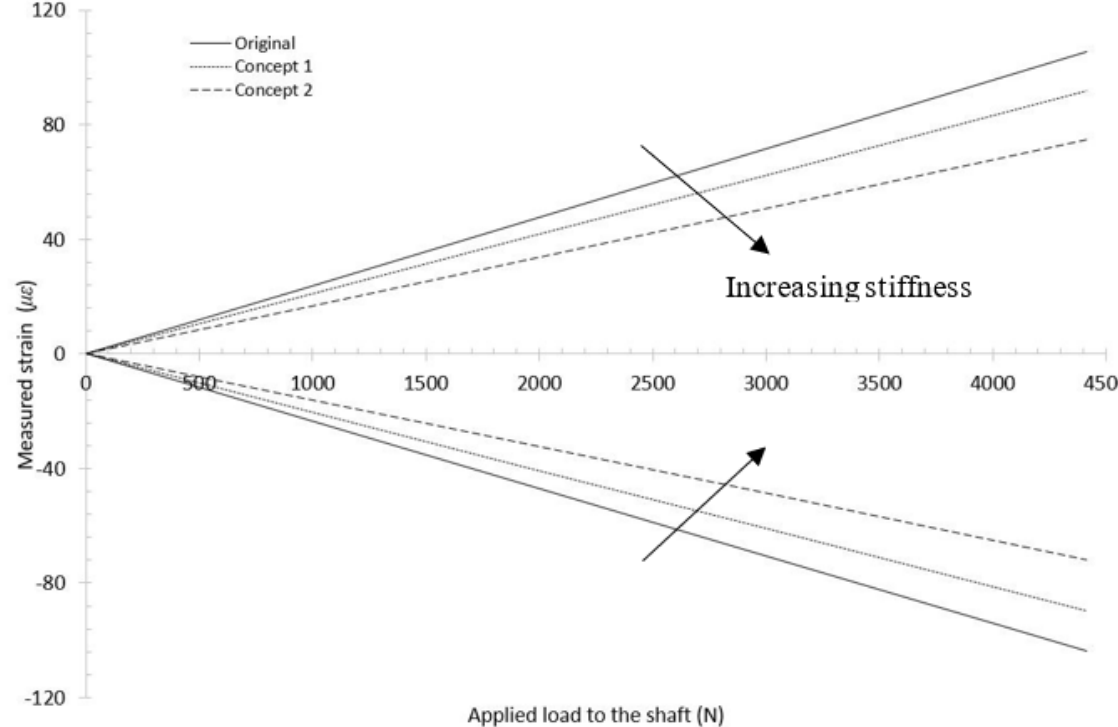
Figure 9: Simulated strain values for alternative laminate